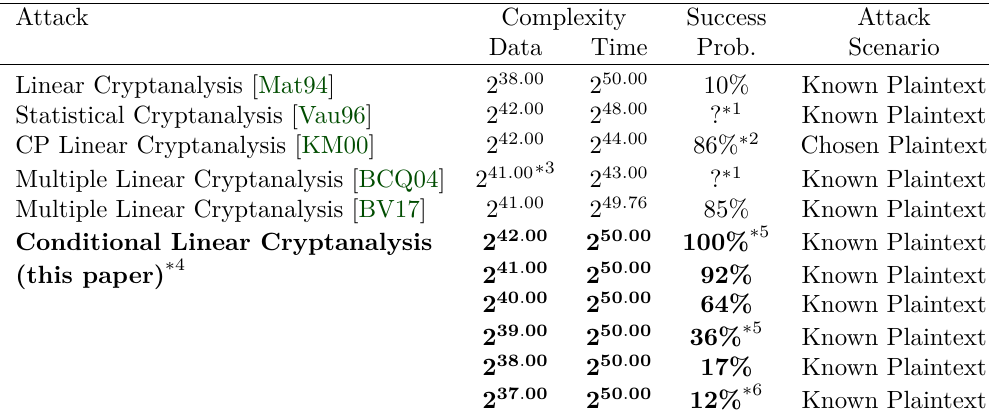
Table 2: Complexity of Attacks Against DES: Time of Analysis ≤ 2 50